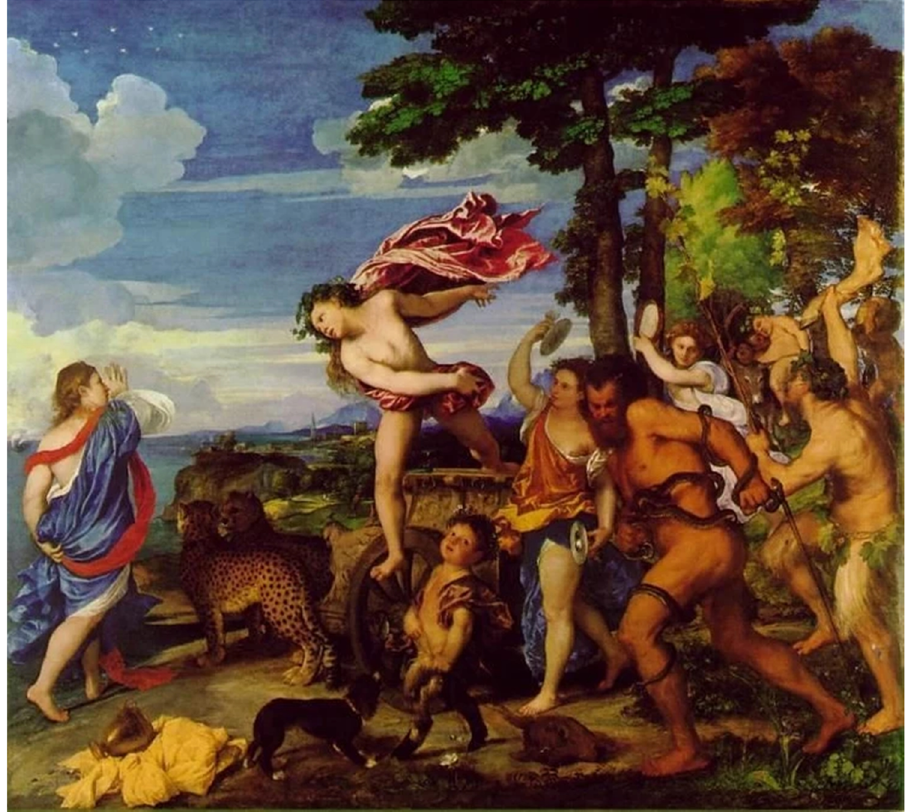
Figure 3: Titian, Bacchus and Ariadne , 1522 – 1523. National Gallery, London. Public